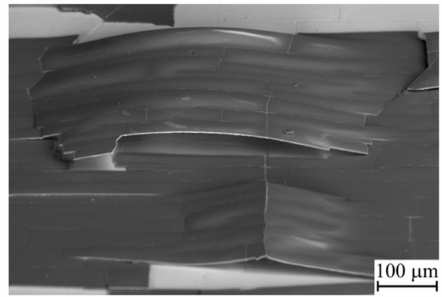
Figure 4. SEM micrographs of Al 0.74 Si 0.26 N coating after 1 thermal